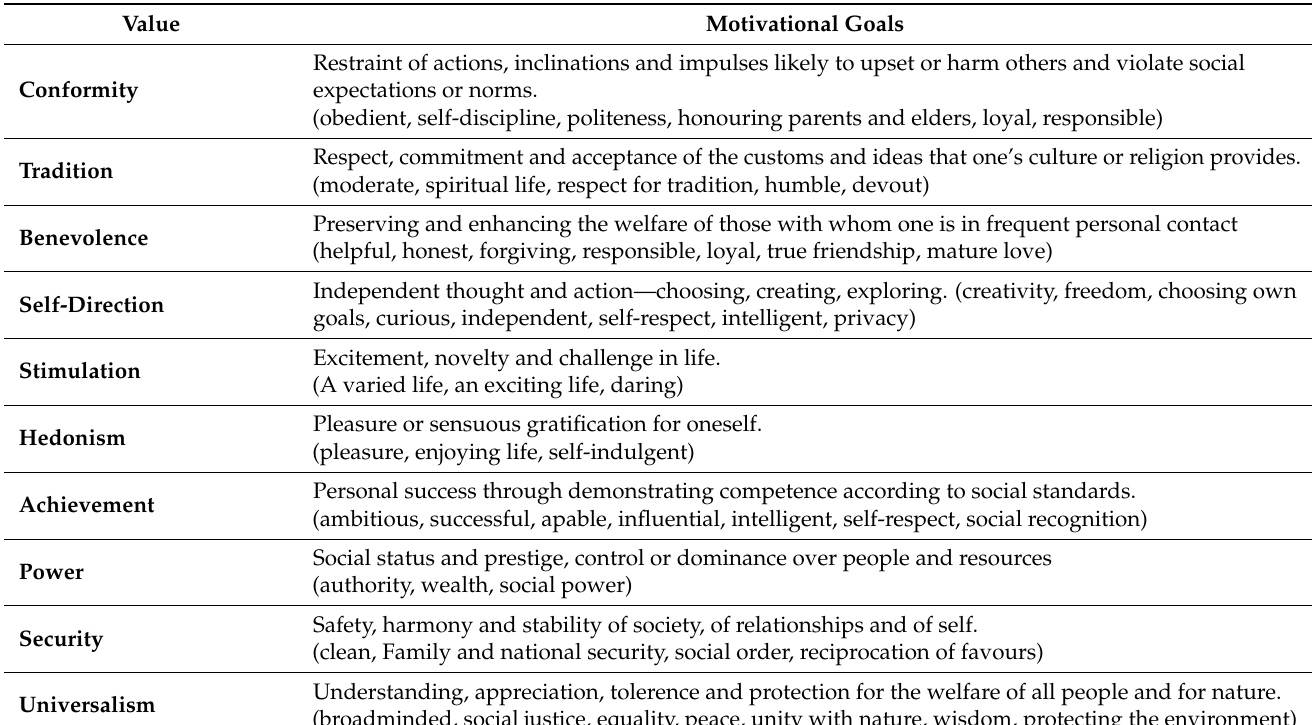
Table 1. Values and the motivational goals—the Schwartz theory of personal values. Value Motivational